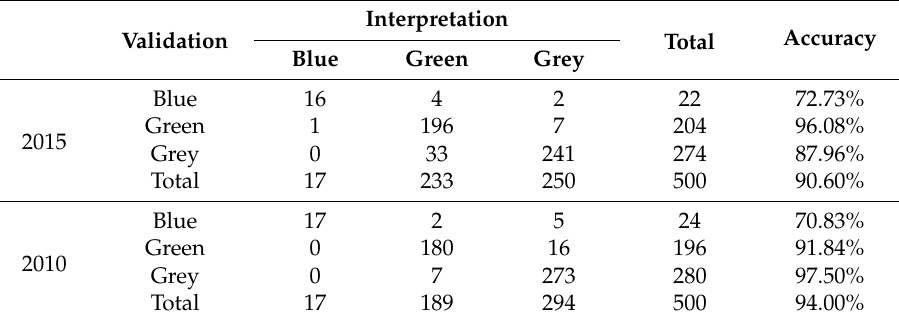
Table 2. Confusion matrix and total accuracy in interpreting landscape